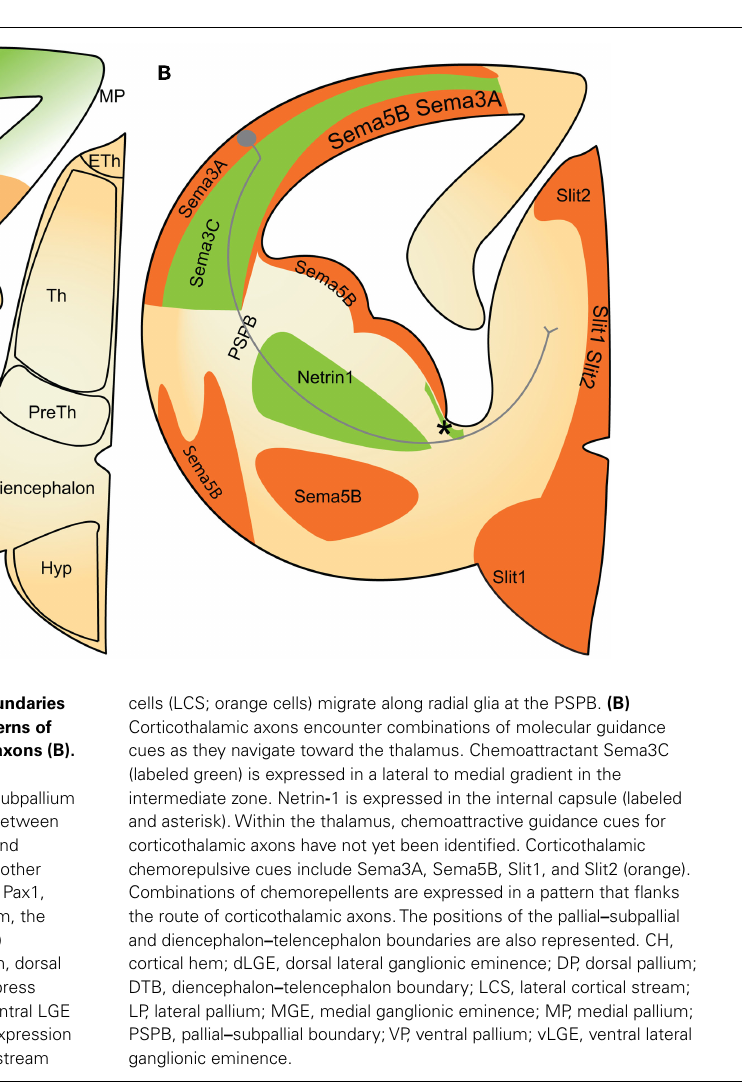
cells (LCS; orange cells) migrate along radial glia at the PSPB. (B) Corticothalamic axons encounter combinations of molecular guidance cues as they navigate toward the thalamus. Chemoattractant Sema3C (labeled green) is expressed in a lateral to medial gradient in the intermediate zone. Netrin - 1 is expressed in the internal capsule (labeled and asterisk).Within the thalamus, chemoattractive guidance cues for corticothalamic axons have not yet been identified. Corticothalamic chemorepulsive cues include Sema3A, Sema5B, Slit1, and Slit2 (orange). Combinations of chemorepellents are expressed in a pattern that flanks the route of corticothalamic axons.The positions of the pallial – subpallial and diencephalon – telencephalon boundaries are also represented. CH, cortical hem; dLGE, dorsal lateral ganglionic eminence; DP, dorsal